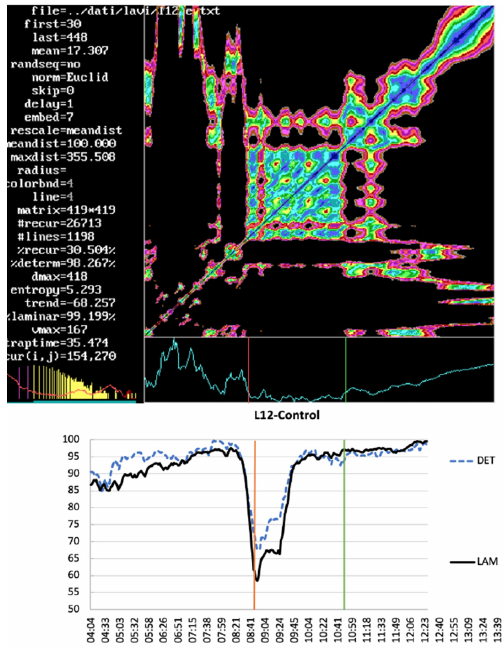
Figure A1. Top panel: the same picture as Figure 5. Bottom panel: the percentage of recurrence points which form diagonal lines (DET) and the percentage of recurrence points which form vertical lines (LAM) epoch by epoch vs. time (min:sec) of detrended RR interval of Figure 5 (light blue line), recorded as a breath-by-breath, from a CPET device (Cosmed, Rome, Italy), in the sub-maximal test where the workload changed every 60 s. The red line highlights the statistically relevant minimum that corresponds to the AerT, and the green line corresponds to the AnT where the percent of determinism reaches saturation (see Appendix A.4).